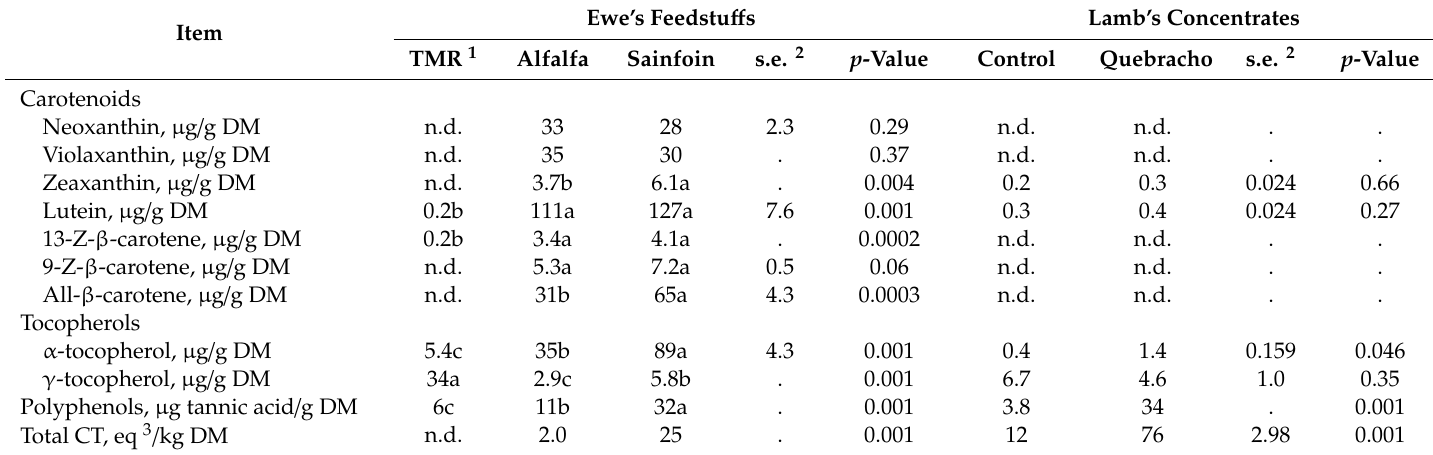
Table 2. Contents of carotenoids, tocopherols, total polyphenols and total condensed tannins (CT) in the feedstu ff s of the ewes and the concentrates of the lambs. Ewe’s Feedstu ff s Lamb’s Concentrates Item TMR 1 Alfalfa Sainfoin s.e. 2 p -Value Control Quebracho s.e. 2 p -Value Carotenoids Neoxanthin, µ g / g DM n.d.